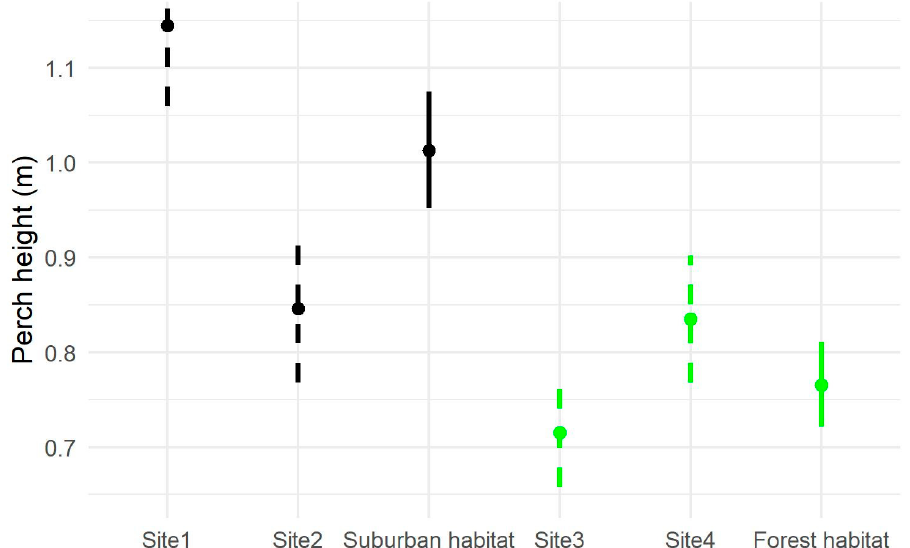
Figure 3. Relationship between snout-vent length and perch height in Anolis homolechis . The solid black line indicates linear regression.